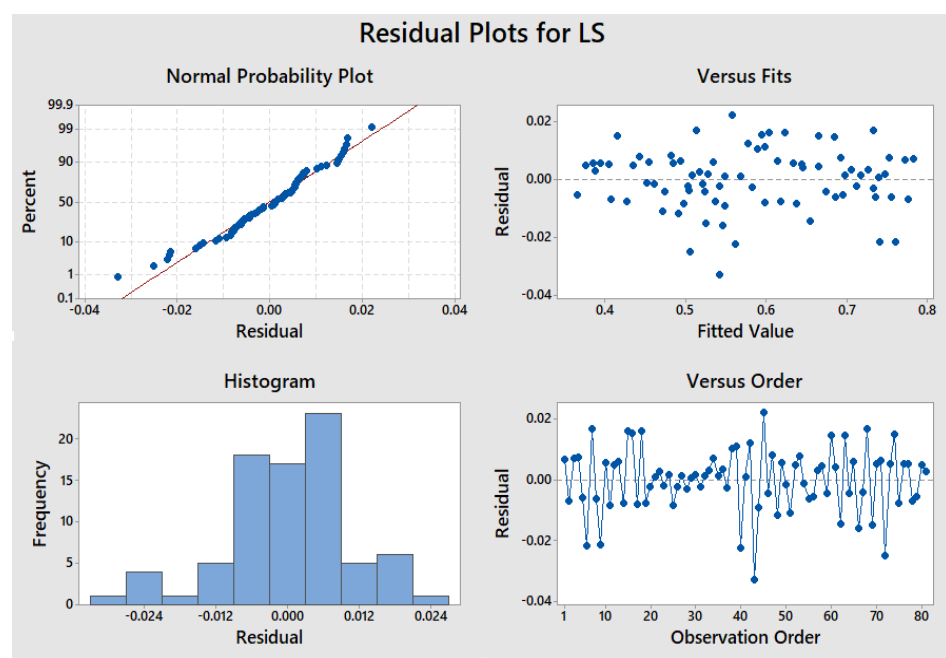
Figure 21. Residual plots of linear shrinkage.